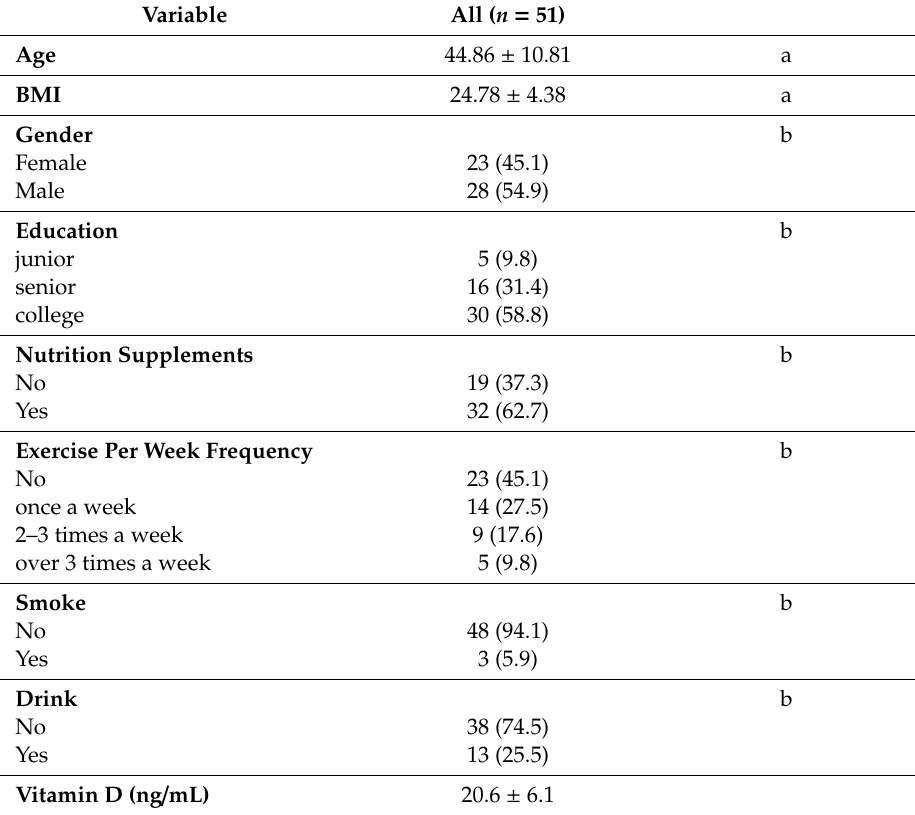
Table 1. Baseline Characteristics of the chronic hepatitis B